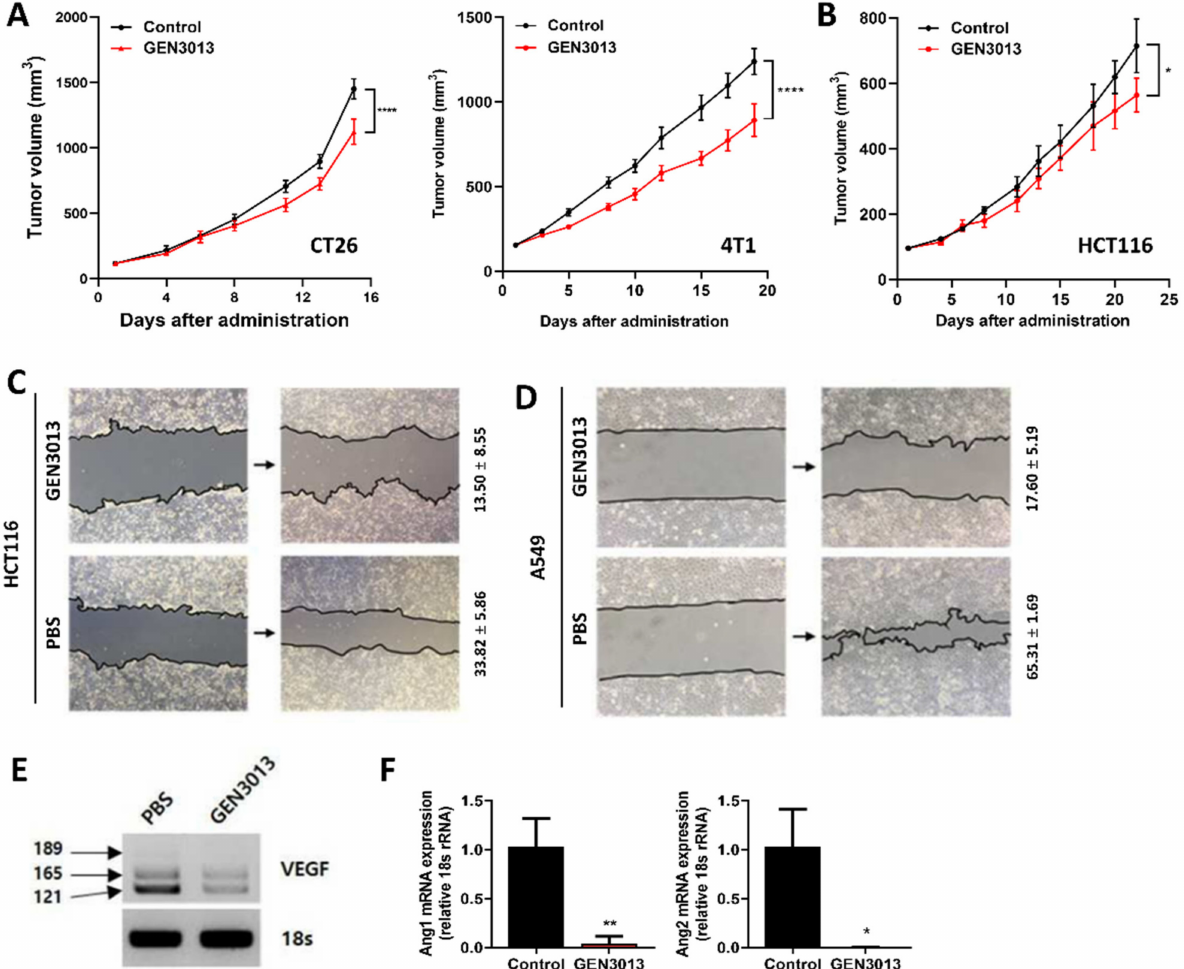
Figure 2. Lactococcus lactis GEN3013 treatment prevents tumor growth through direct effects on cancer cells. ( A ) Nude mice were inoculated with mouse cancer cell lines, CT26 (N = 7 per group) and 4T1 (N = 10 per group), respectively, 14 days after the initial oral administration of L. lactis GEN3013. While L. lactis GEN3013 was orally administered daily to mice, the tumor growth was measured three times a week. L. lactis GEN3013 versus control: CT26, p ≤ 0.0001; 4T1, p ≤ 0.0001. ( B ) Nude mice were inoculated with HCT116 human cancer cells (N = 5 per group). L. lactis GEN3013 versus control: p = 0.0239. ( C , D ) The mobility of HCT116 cells or A549 cells was measured using a wound-healing assay and calculated relative to the status of the zero time point of cell damage. ( C ) L. lactis GEN3013 treatment, 13.50% ± 8.55%; PBS treatment, 33.82% ± 5.86%. ( D ) L. lactis GEN3013 treatment, 17.60% ± 5.19%; PBS treatment, 65.31% ± 1.69%. ( E ) VEGF expression